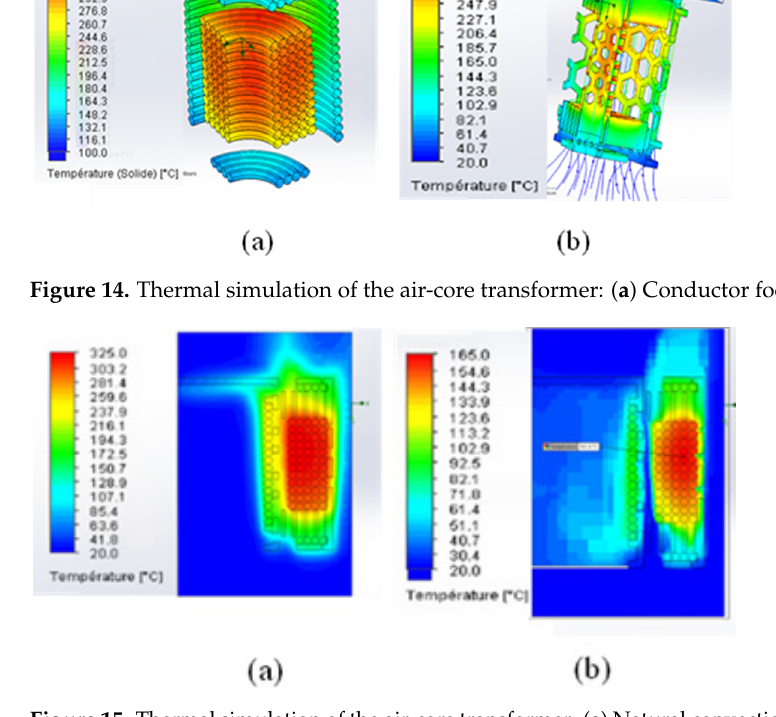
Figure 15. Thermal simulation of the air-core transformer: ( a ) Natural convection; ( b ) Forced con-